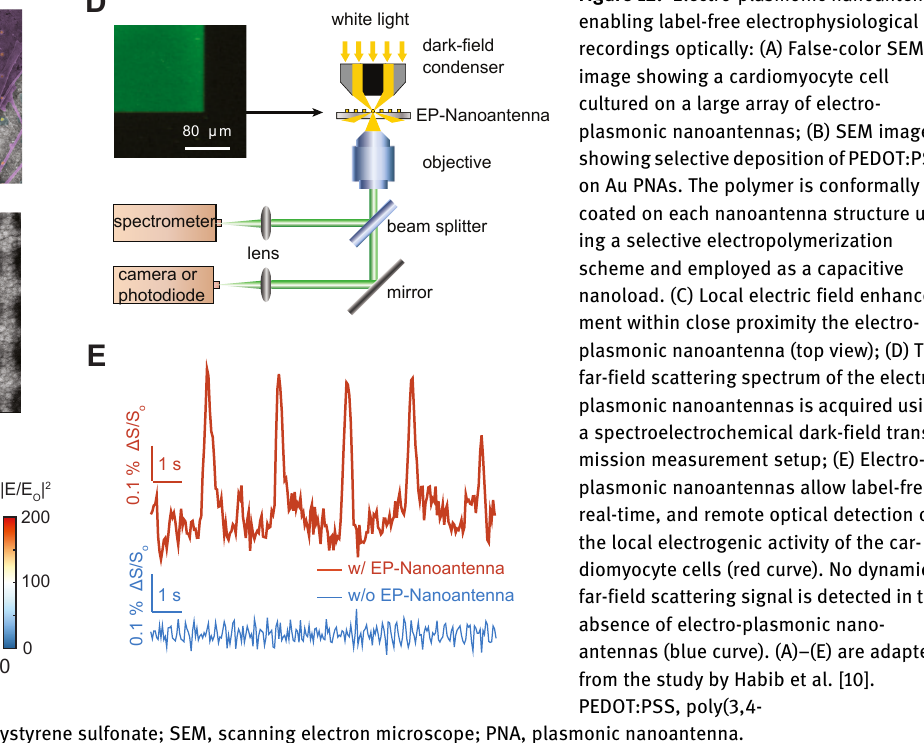
Figure 12: Electro-plasmonic nanoantenna enabling label-free electrophysiological recordings optically: (A) False-color SEM image showing a cardiomyocyte cell cultured on a large array of electro- plasmonic nanoantennas; (B) SEM image showingselectivedepositionofPEDOT:PSS on Au PNAs. The polymer is